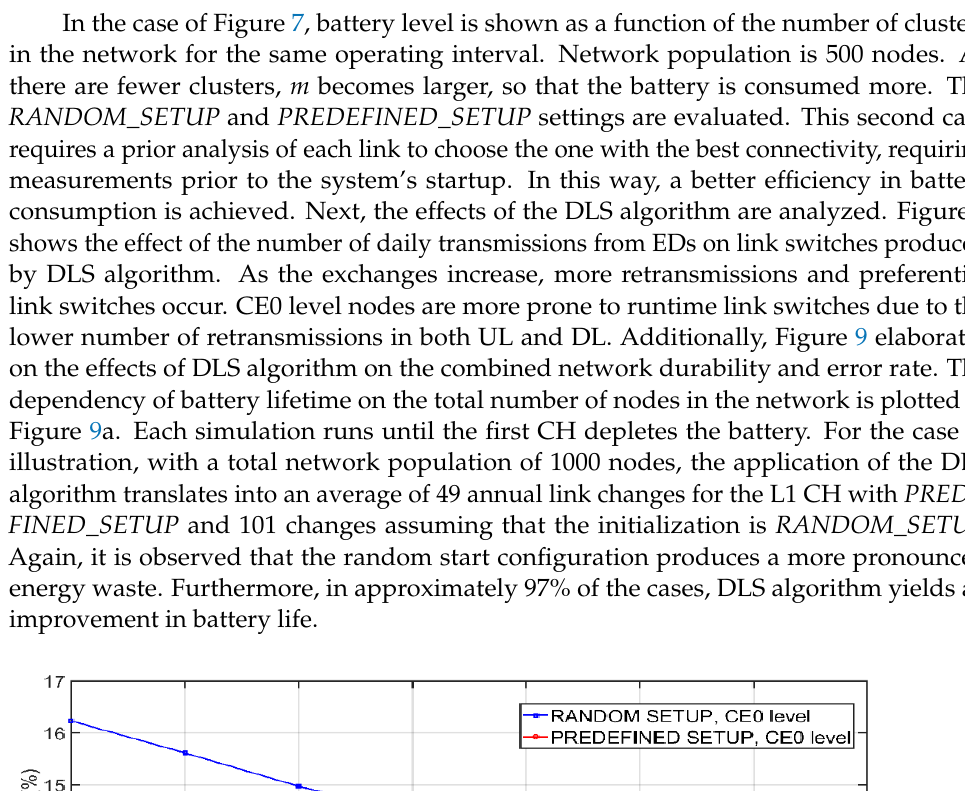
Figure 8. Number of link switches as a function of daily data rate. ( a ) ( b ) Figure 9. Effects of DLS algorithm on the combined network as a function of network population: ( a ) battery lifetime; ( b ) packet error rate.